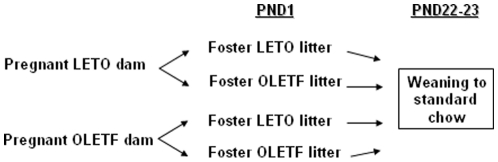
Experimental Design.